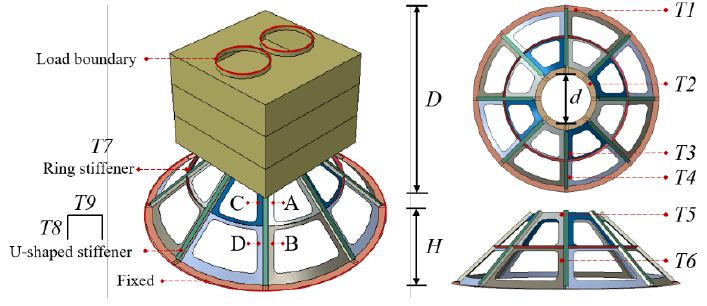
Figure 14. Geometry parameters of PAF.